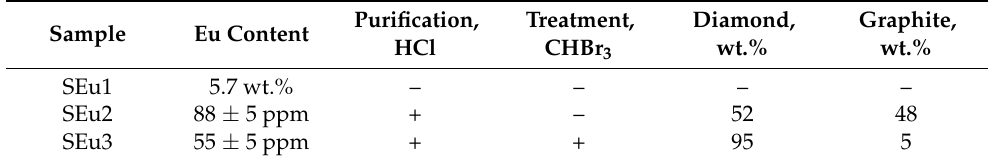
Table 1. Diamond containing samples with